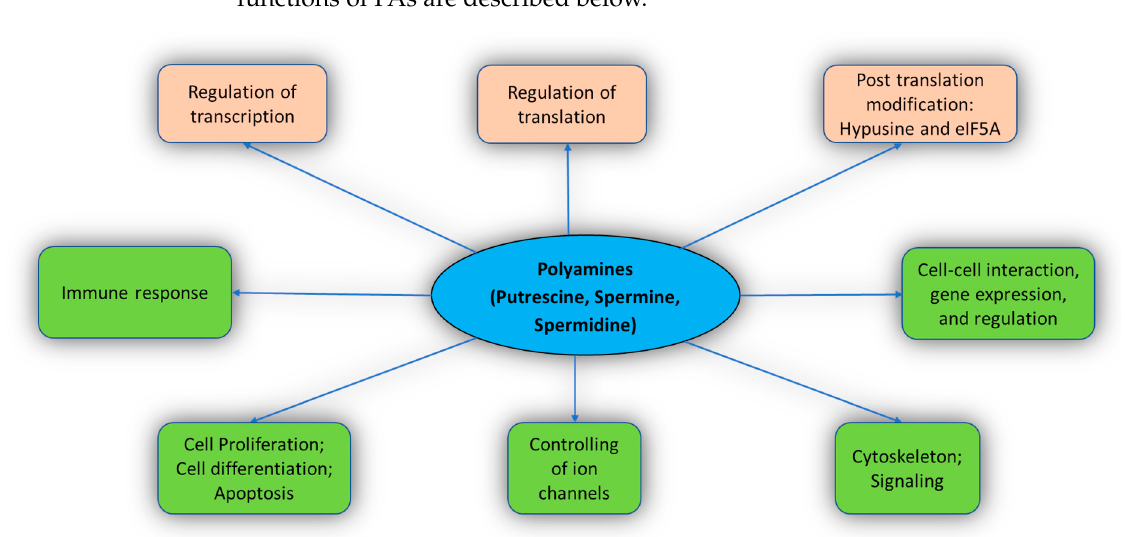
Figure 2. Biological functions related to polyamines.